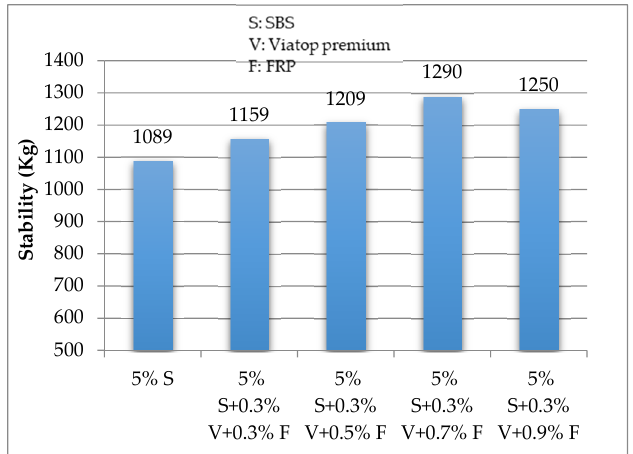
Figure 1. Results of Marshall Stability test.